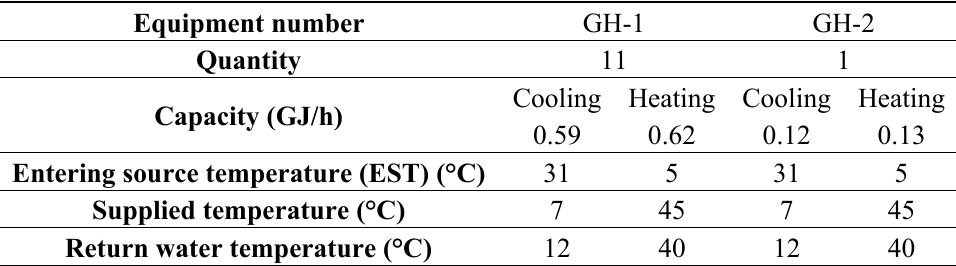
Table 3. Multi-GHP system information.